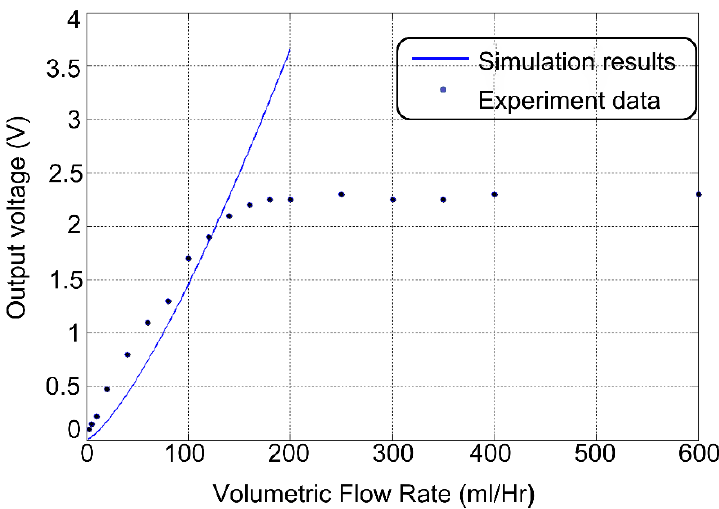
Figure 11. Output voltage versus the volumetric flow rate ranges between 2 mL/h and 400